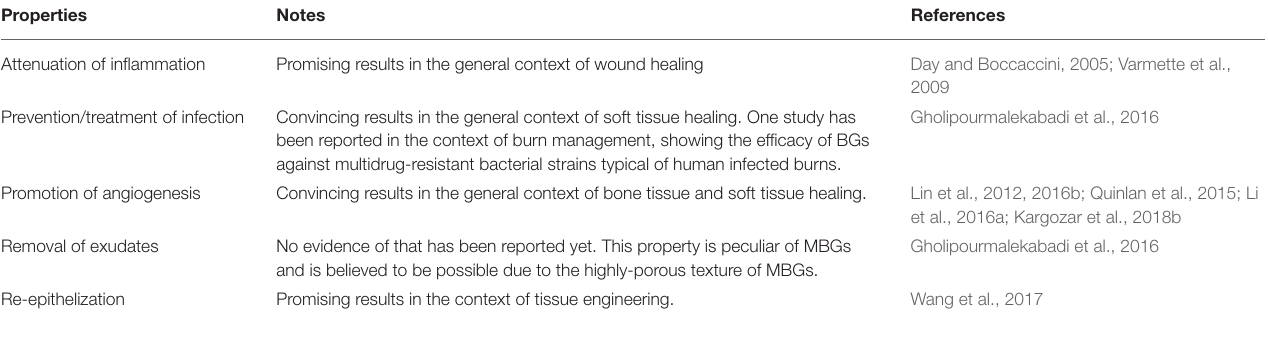
TABLE 3 | Potential capability of BGs to meet the criteria required for burn management.